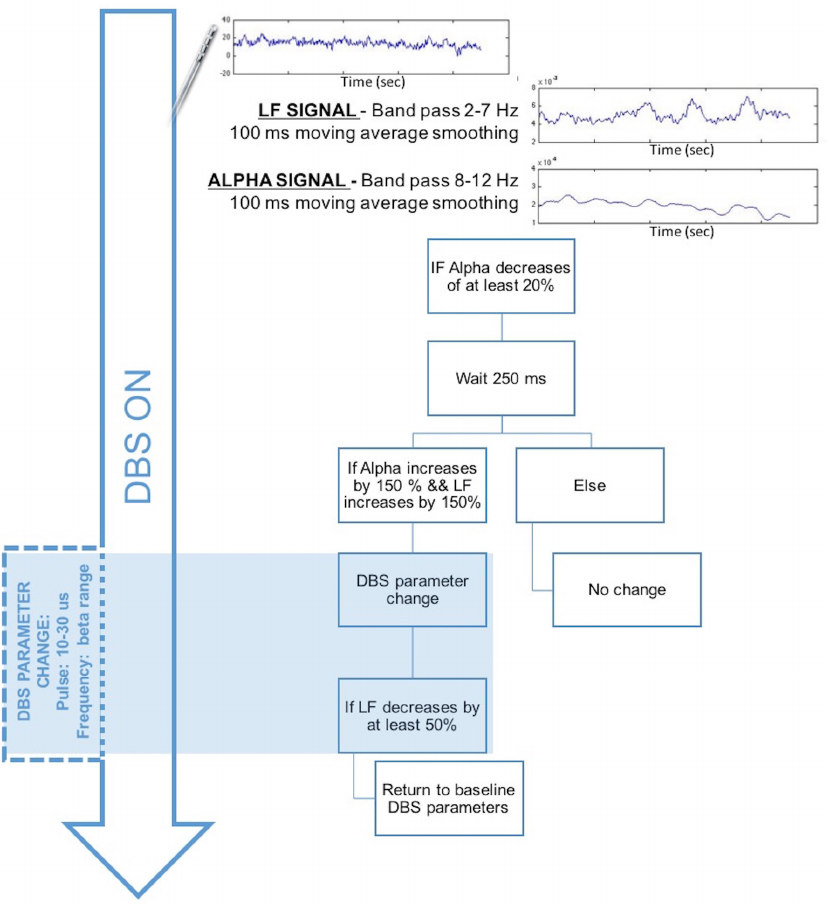
Figure 5. Hypothesized adaptive feed-forward strategy for fast changes in deep brain stimulation (DBS) parameters to control tics. LF = low-frequencies band (2–7 Hz), ALPHA = alpha band (8–13 Hz).